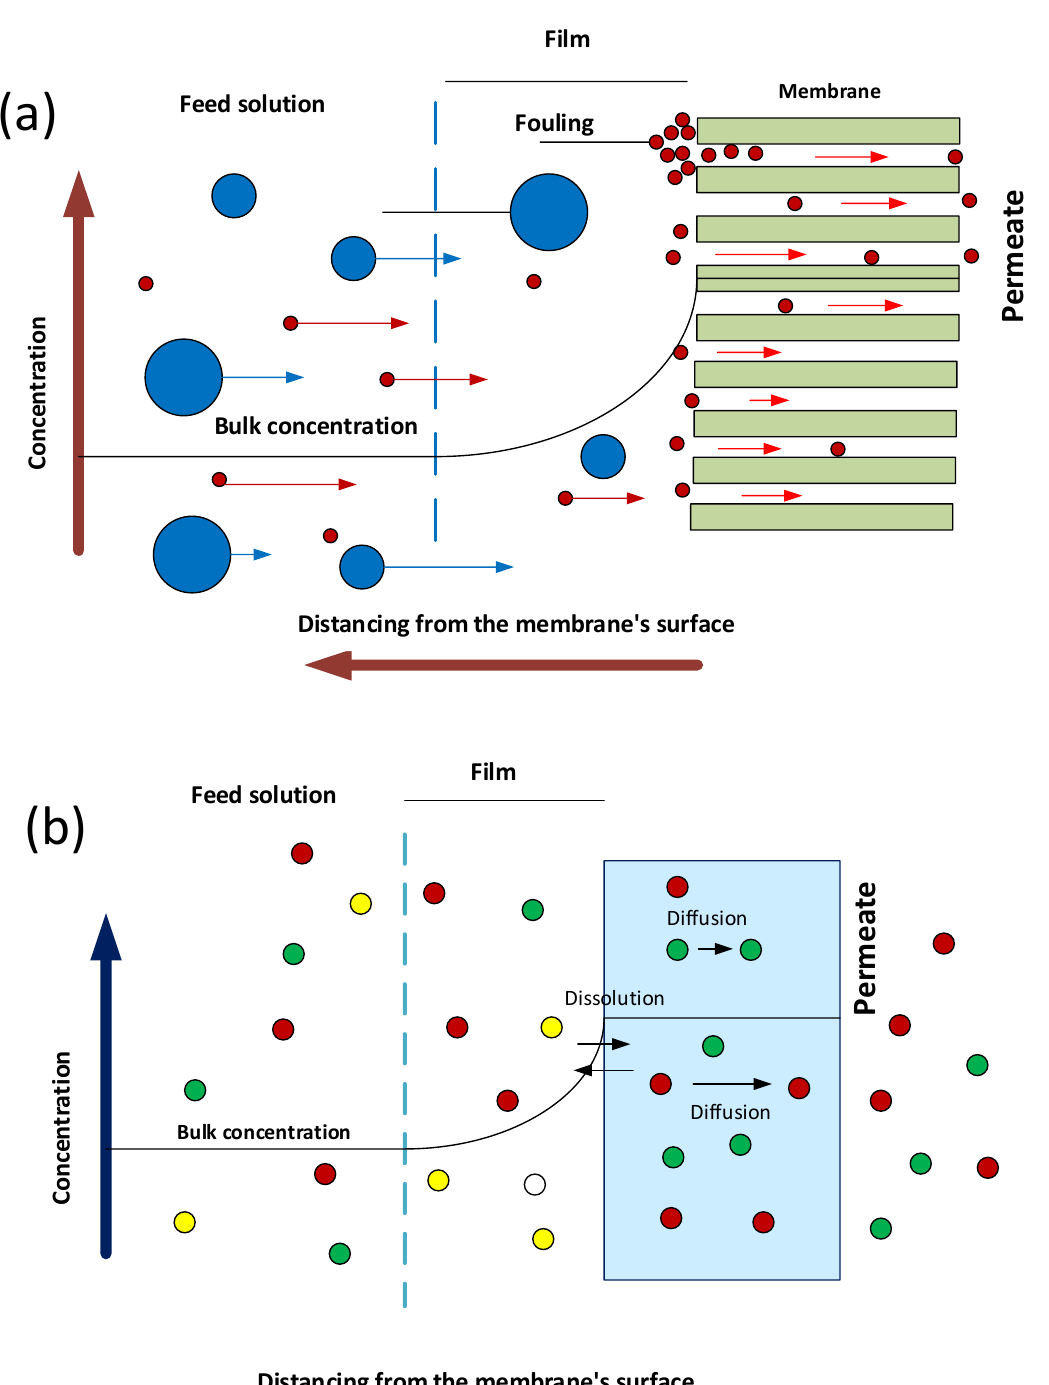
Figure 8. Separation by size-based exclusion ( a ) and dissolution–diffusion ( b )